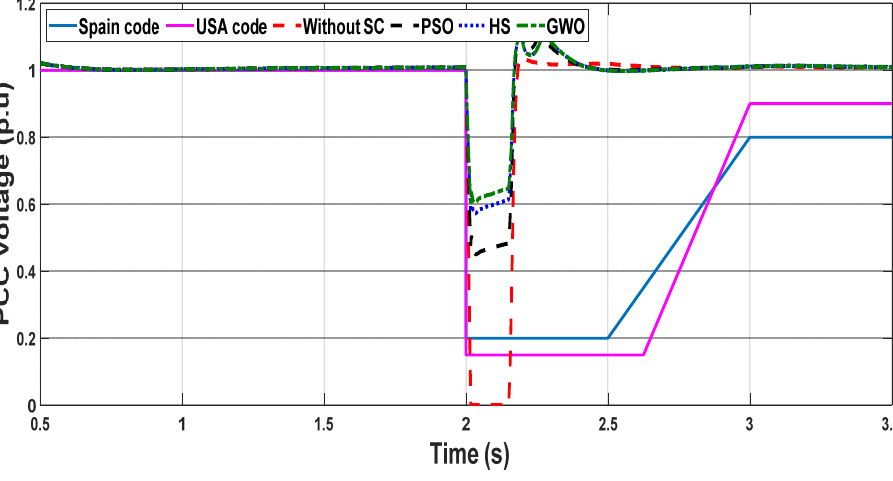
Figure 11. DC-link voltage during the three-phase fault case study. ( a )